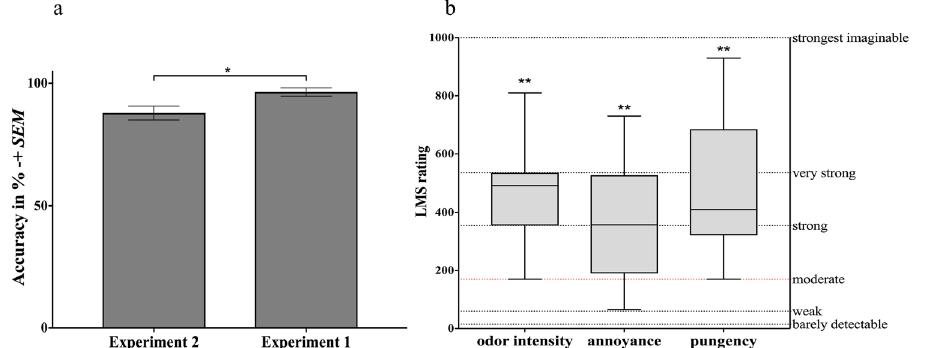
Figure 6. Behavioral data including ( a ) lateralization performance expressed in accuracy (%) + / − SEM for experiment 1 and AcOH of experiment 2 and ( b ) LMS ratings for ‘odor intensity’, ‘annoyance’, and ‘pungency’. The dotted red line indicates the minimum rating required to be categorized as ‘irritating’. * p < 0.05, ** p <